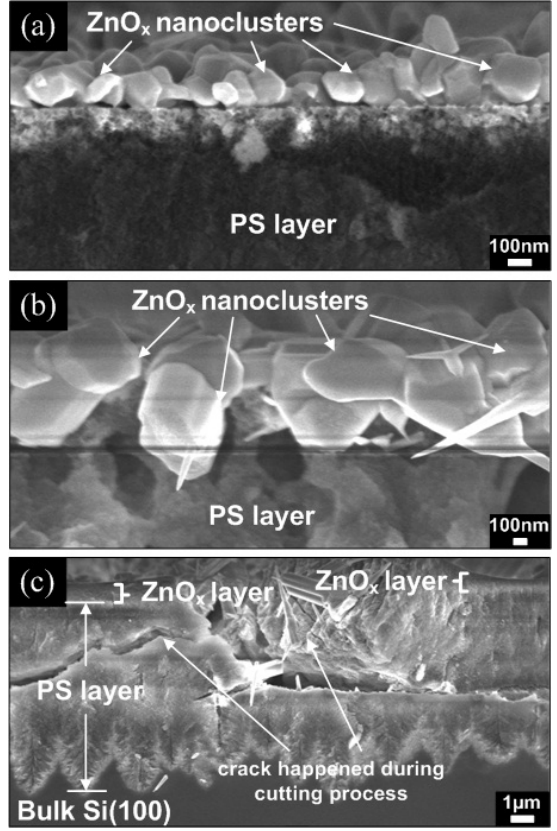
Figure 8. Cross sectional FESEM images of ZnO substrates at ( a ) 600 °C; ( b ) 800 °C and ( c ) 1000 °C,